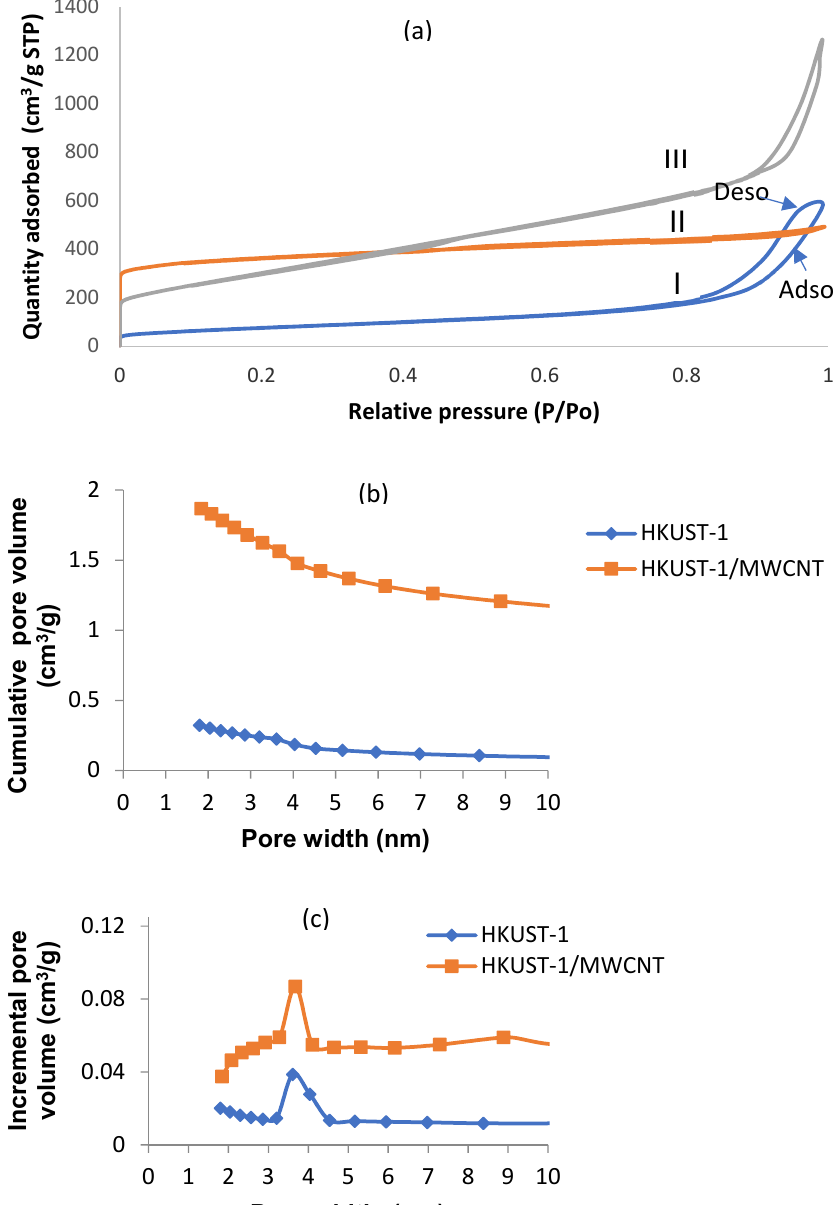
Figure 7. ( a ) N 2 adsorption / desorption isotherms of (I) as-received MWCNTs, (II) HKUST-1, and (III) FMWCNT / HKUST-1, and BJH pore size distributions of MOF and HKUST-1 composite samples; ( b ) cumulative pore volume; ( c ) incremental pore